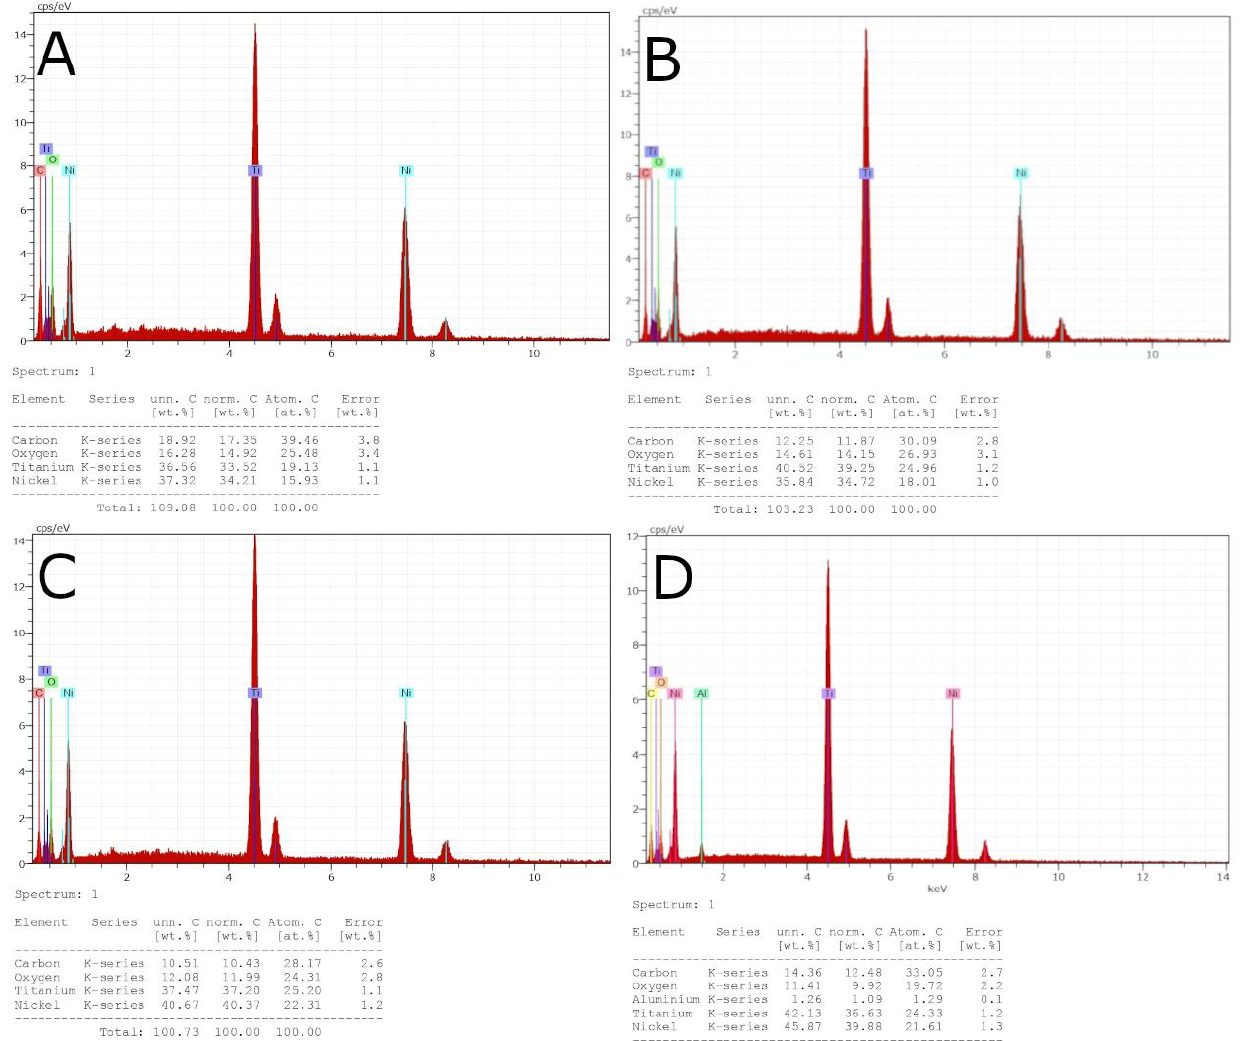
Figure 2. ( A ) EDX micro-analysis of the 25.06 CM Gold wire NiTi alloy endodontic rotary files, 31 mm in length; ( B ) 25.06 CM Gold wire NiTi alloy endodontic rotary files, 25 mm in length; ( C ) 25.06 CM Gold wire NiTi alloy endodontic rotary files, 21 mm in length; and ( D ) 25.06 CM Blue wire NiTi alloy endodontic rotary files, 17 mm in length.